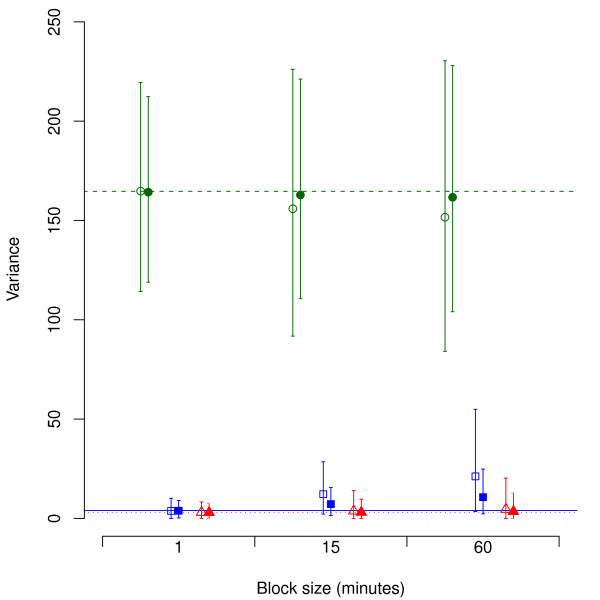
Estimated variance component mean values (error bars: 90% prediction intervals) resulting from simulations of six different sampling strategies assessing percentage time above 90°. All six strategies used random sampling from ns = 10 subjects, approached for nd = 2 days each. Green circles, blue squares and red triangles show within-day, between-days and between-subjects variance, respectively. Unfilled and filled symbols show strategies with ttot = 120 minutes and ttot = 240 minutes, respectively. Red dashed, blue solid and green dotted lines represent the “true” within-day, between-days and between-subjects variance, respectively, according to the parent data set